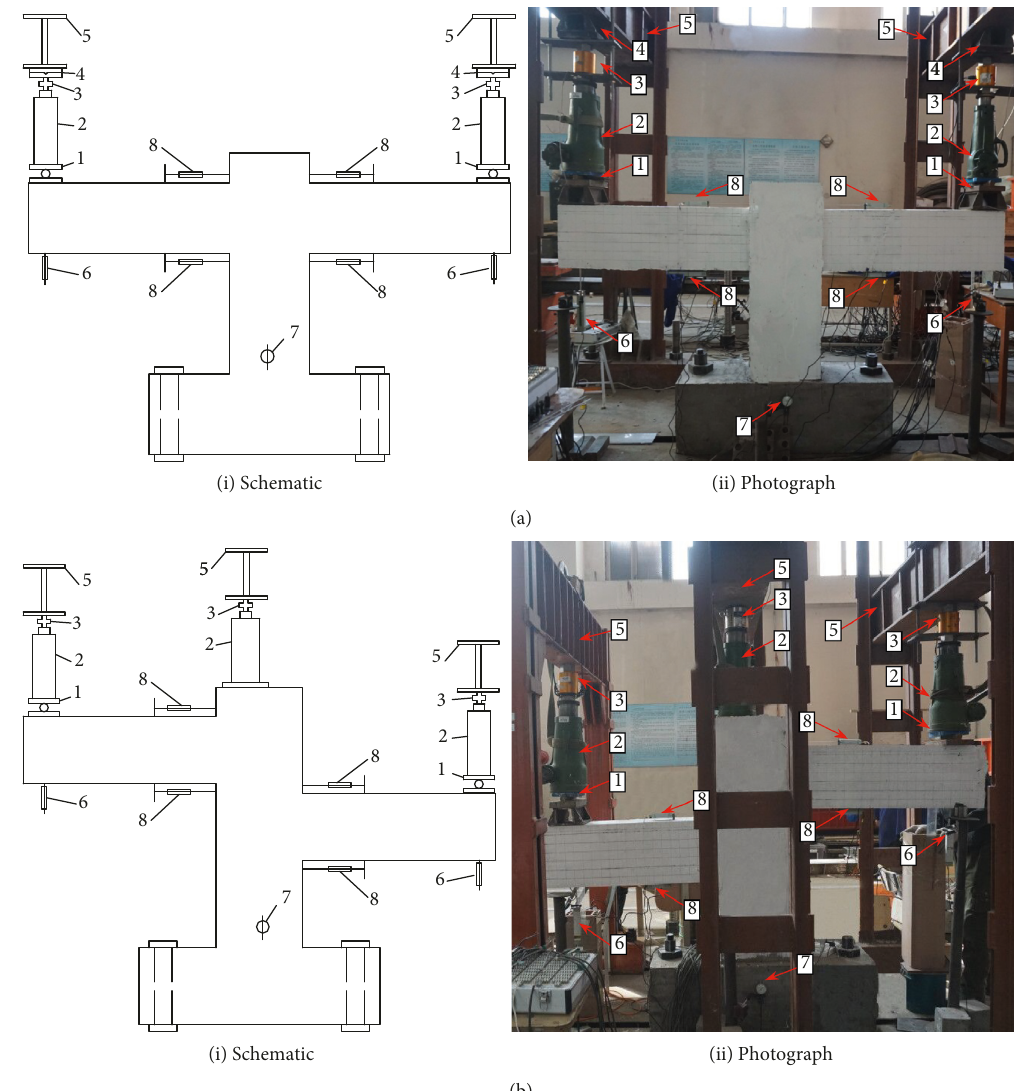
Figure 3: Test rigs and instrumentations. (a) Interior beam-column connection test: (i) schematic; (ii) photograph. (b) Exterior beam- column connection test: (i) schematic; (ii) photograph. (1) Rolling hinge support. (2) Loading jack. (3) Loading sensor. (4) Blade hinge support. (5) Trestle. (6) Displacement transducers. (7) Dial indicator. (8)